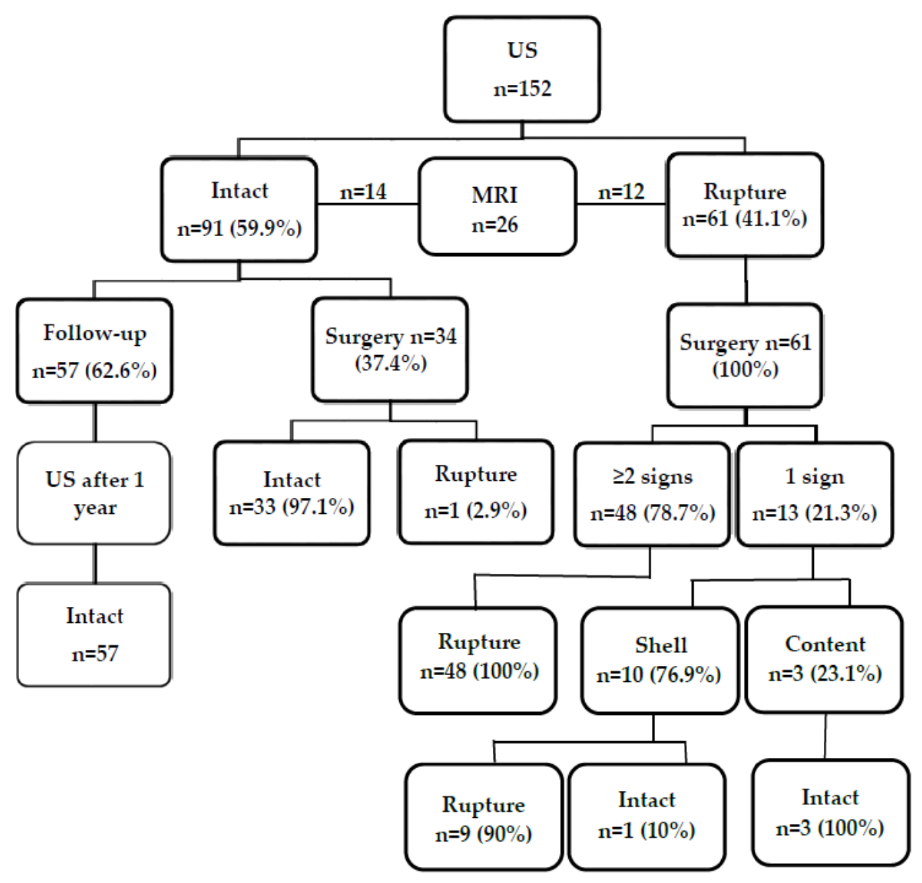
Figure 4. Flowchart showing the findings on ultrasound, magnetic resonance imaging, and at surgery. Breast MRI was performed in 17.1% of cases ( n = 26). Of them, 14 (53.8%) were intact based on the findings on MRI and confirmed during surgery, while in 46.2% ( n = 12), MRI showed a ruptured implant (Figure 4). However, the rupture was confirmed during surgery in 11 cases. One flipped-over but not ruptured implant was detected (Figure